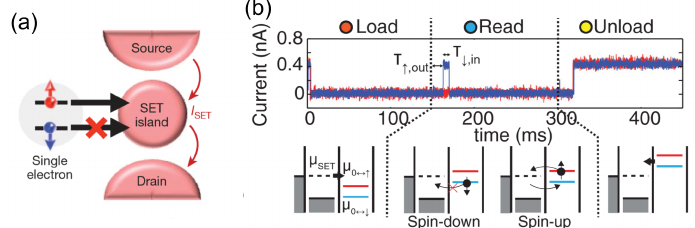
Figure 2. ( a ) schematic of single shot readout of a single phosphorus atom with an SED. Zeeman-split spin up electrons tunnel to the single electron transistor (SET) giving a current pulse while spin down electrons do not tunnel since that process is energetically uphill and do not give a current pulse on the SET. Reproduced with permission from reference [33], Copyright 2010, Nature Publishing Group; ( b ) pulse sequence which loads an electron from the SET island (acting as a reservoir), reads the electron state, and then empties the donor to reinitialize. Current traces for different spin states. Reproduced with permission from reference [34], Copyright 2015, American Physical